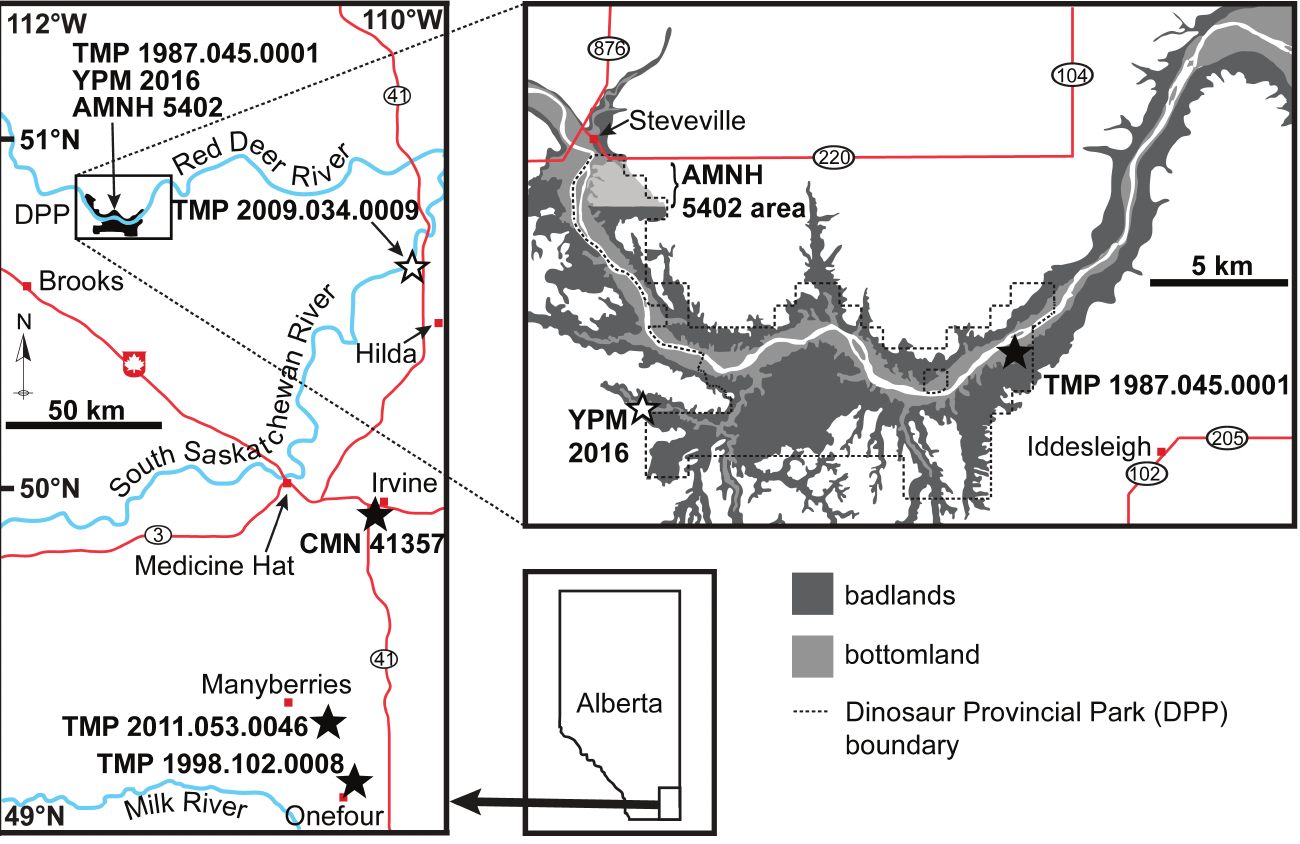
Figure 1. Regional map of localities producing ‘ Vagaceratops ’ irvinensis specimens (solid black stars; CMN 41357, TMP 1987.045.0001, TMP 1998.102.0008, and TMP 2011.053.0046) and ‘ V. ’ irvinensis -like Chasmosaurus sp. specimens (empty black stars; AMNH 5402, TMP 2009.034.0009, and YPM 2016). AMNH 5402 was collected “in Township 21, Range 12, about 1 mile below Steveville, on the left bank of the river” (Lull 1933:12); the general area this encompasses is shown in light